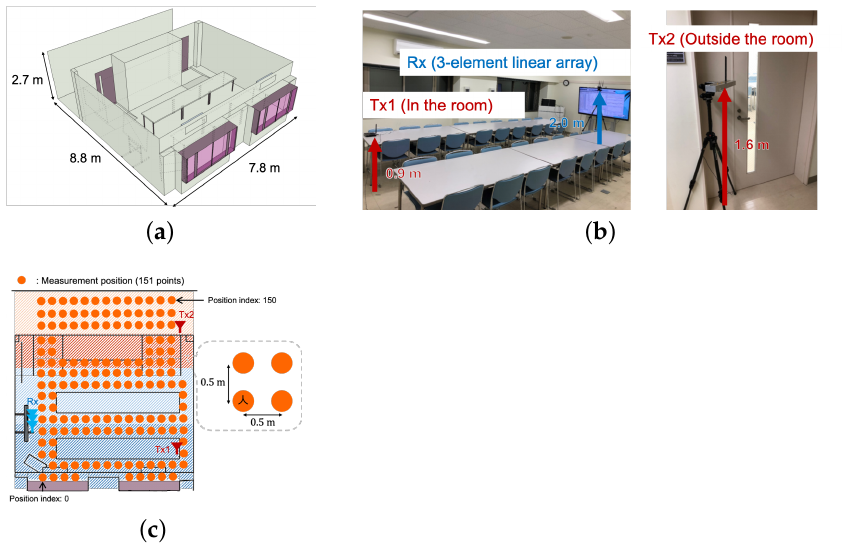
Figure 10. Conference room condition. ( a ) Room model. ( b ) Antenna position. ( c ) Human